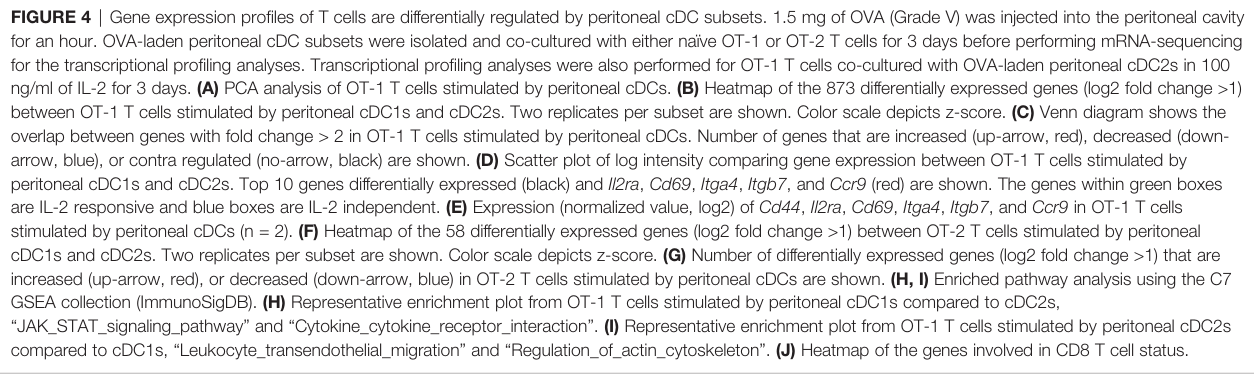
FIGURE 4 | Gene expression pro fi les of T cells are differentially regulated by peritoneal cDC subsets. 1.5 mg of OVA (Grade V) was injected into the peritoneal cavity for an hour. OVA-laden peritoneal cDC subsets were isolated and co-cultured with either naïve OT-1 or OT-2 T cells for 3 days before performing mRNA-sequencing for the transcriptional pro fi ling analyses. Transcriptional pro fi ling analyses were also performed for OT-1 T cells co-cultured with OVA-laden peritoneal cDC2s in 100 ng/ml of IL-2 for 3 days. (A) PCA analysis of OT-1 T cells stimulated by peritoneal cDCs. (B) Heatmap of the 873 differentially expressed genes (log2 fold change >1) between OT-1 T cells stimulated by peritoneal cDC1s and cDC2s. Two replicates per subset are shown. Color scale depicts z-score. (C) Venn diagram shows the overlap between genes with fold change > 2 in OT-1 T cells stimulated by peritoneal cDCs. Number of genes that are increased (up-arrow, red), decreased (down- arrow, blue), or contra regulated (no-arrow, black) are shown. (D) Scatter plot of log intensity comparing gene expression between OT-1 T cells stimulated by peritoneal cDC1s and cDC2s. Top 10 genes differentially expressed (black) and Il2ra , Cd69 , Itga4 , Itgb7 , and Ccr9 (red) are shown. The genes within green boxes are IL-2 responsive and blue boxes are IL-2 independent. (E) Expression (normalized value, log2) of Cd44 , Il2ra , Cd69 , Itga4 , Itgb7 , and Ccr9 in OT-1 T cells stimulated by peritoneal cDCs (n = 2). (F) Heatmap of the 58 differentially expressed genes (log2 fold change >1) between OT-2 T cells stimulated by peritoneal cDC1s and cDC2s. Two replicates per subset are shown. Color scale depicts z-score. (G) Number of differentially expressed genes (log2 fold change >1) that are increased (up-arrow, red), or decreased (down-arrow, blue) in OT-2 T cells stimulated by peritoneal cDCs are shown. (H, I) Enriched pathway analysis using the C7 GSEA collection (ImmunoSigDB). (H) Representative enrichment plot from OT-1 T cells stimulated by peritoneal cDC1s compared to cDC2s, “ JAK_STAT_signaling_pathway ” and “ Cytokine_cytokine_receptor_interaction ” . (I) Representative enrichment plot from OT-1 T cells stimulated by peritoneal cDC2s compared to cDC1s, “ Leukocyte_transendothelial_migration ” and “ Regulation_of_actin_cytoskeleton ” . (J) Heatmap of the genes involved in CD8 T